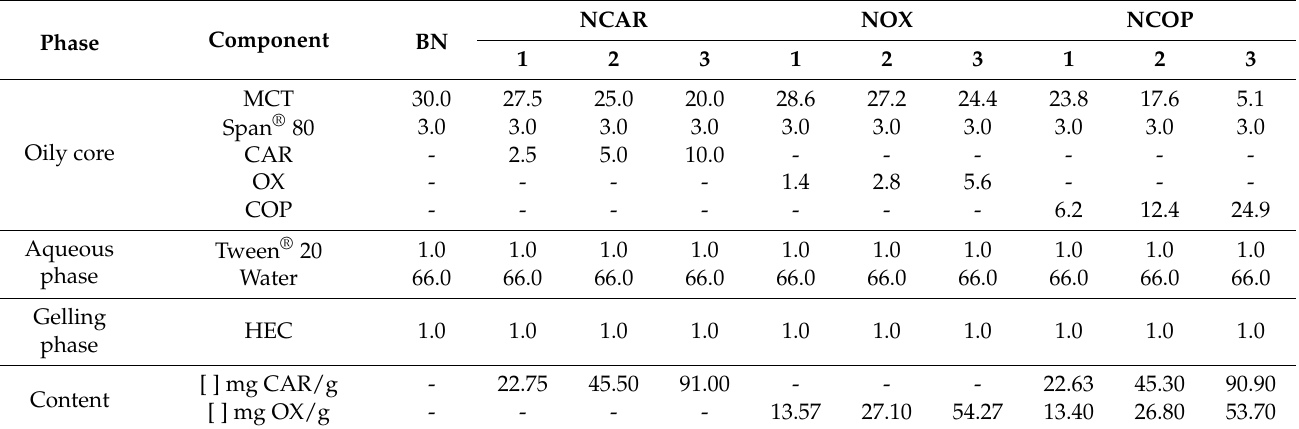
Table 1. Percentage composition (% w / w ) of COP, CAR, and OX nanoemulgels.